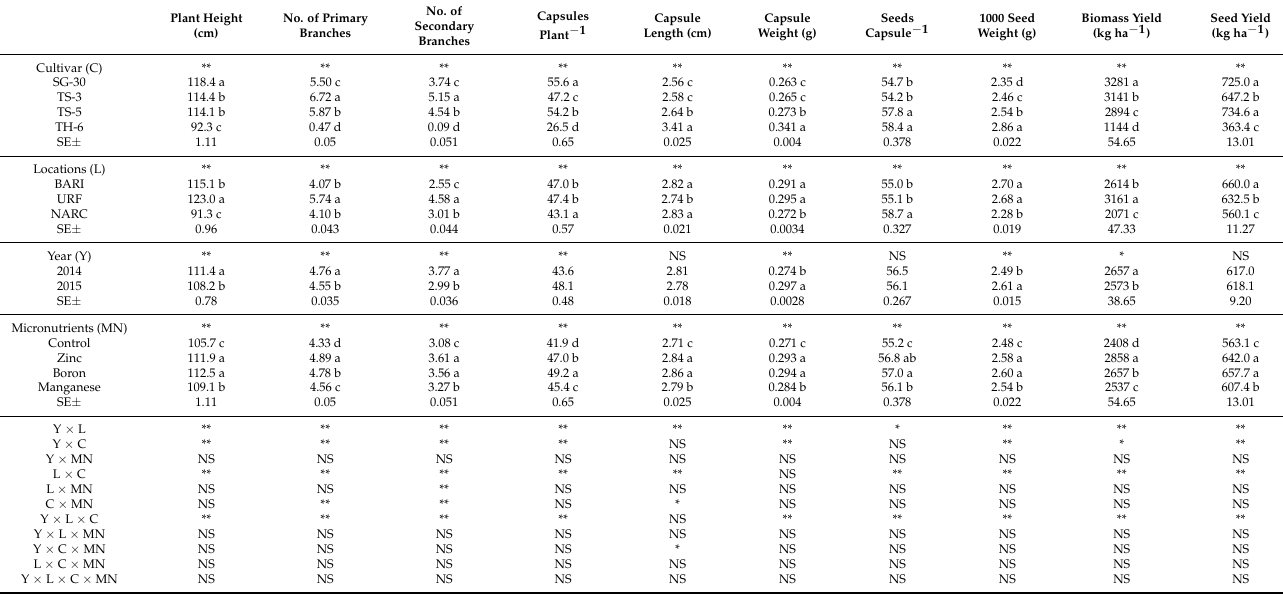
Table 2. Main and interactive effects of cultivars, micronutrients, locations and years for growth and yield attributes of